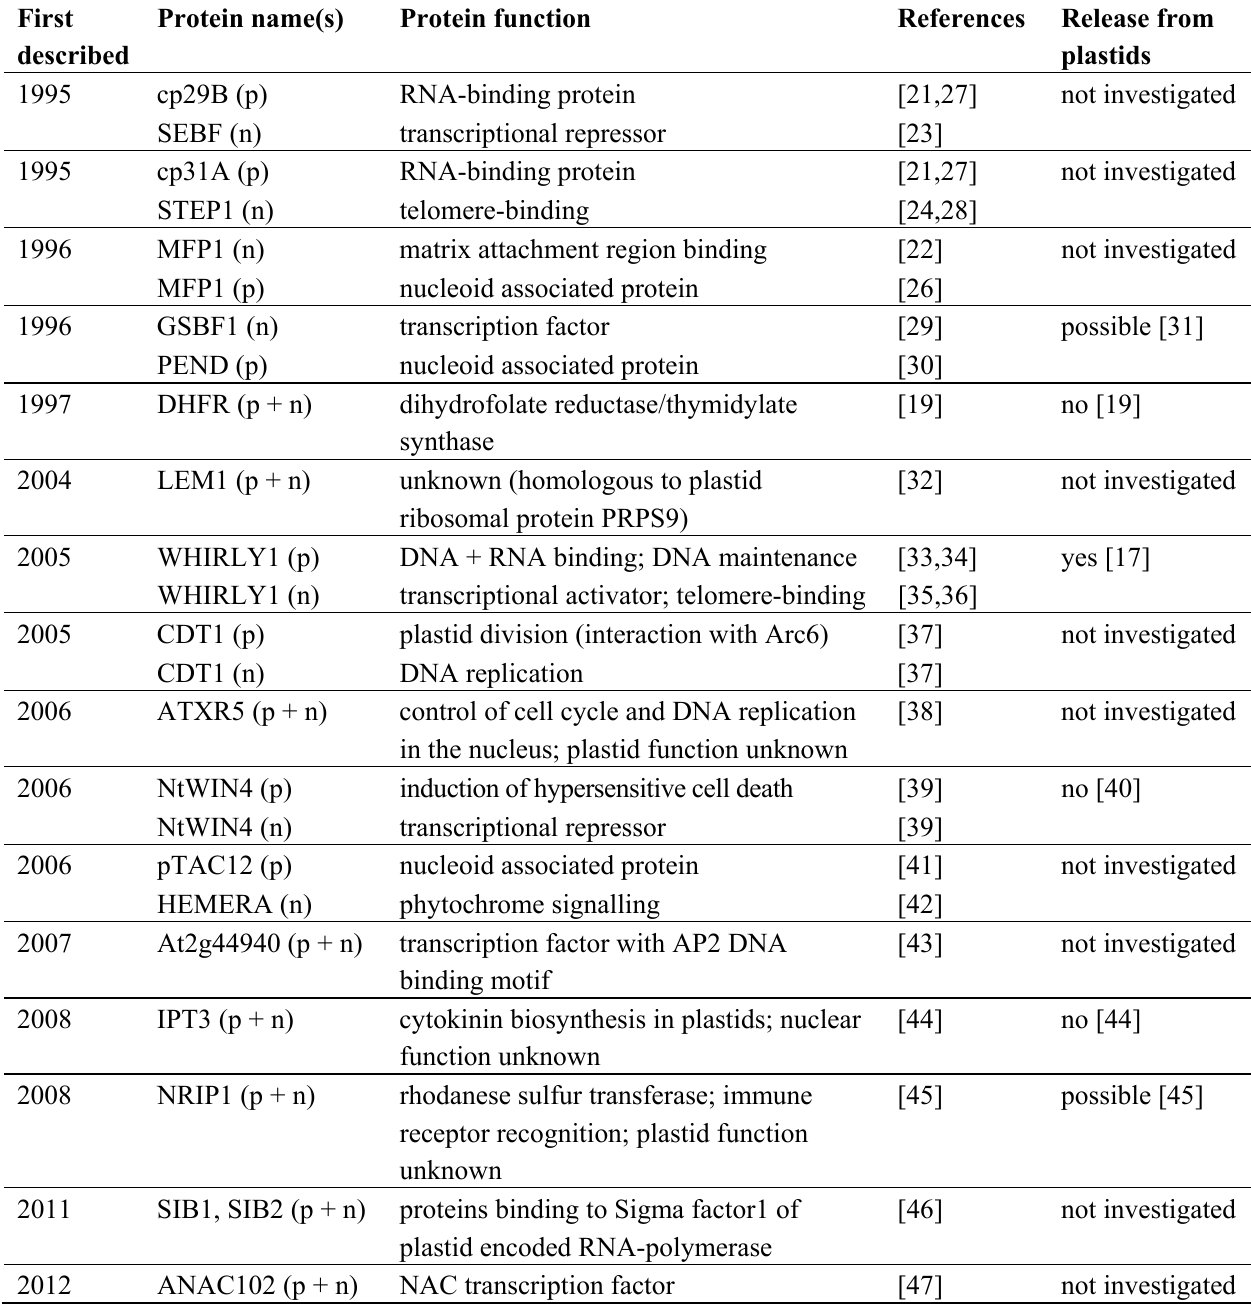
Table 1. List of proteins that are targeted to the plastids (p) and the nucleus